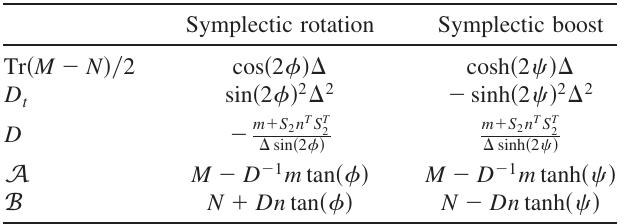
TABLE I. Comparison of the method of symplectic rotation with the symplectic ‘‘Lorentz boost.’’ The difference (cid:1) is Þ (cid:1) cos ð (cid:10) Þ . The matrix S is defined defined by (cid:1) (cid:4) cos ð (cid:10) 1 2 2 ¼ ð 0 Þ and D D ¼ 2 Det ð m Þ þ Tr ð nm Þ . 1 by S t is defined by t (cid:1) 1 2 0 Symplectic rotation Symplectic